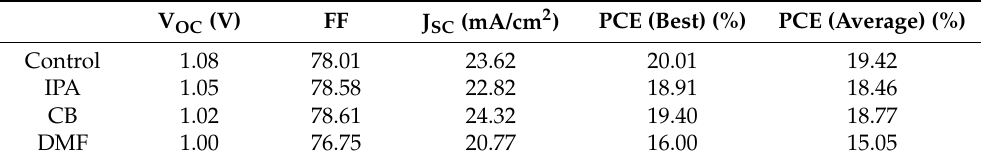
Table 2. Photovoltaic parameters of the controlled, IPA-, CB- and DMF-treated PSCs under one sun